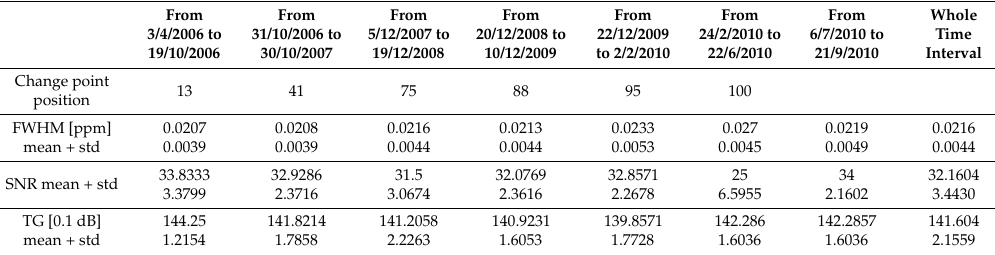
Table 2. Mean values (mean) and standard deviation (std) of full width at half maximum (FWHM), signal-to-noise ratio (SNR) and transmitter gain (TG) of the spectra averaged for the time intervals detected by the change point analysis. FWHM and SNR (the ratio of the maximum in the spectrum-minus baseline over the analysis window to twice the root mean squares of residuals) are the main spectral quality parameters determined with use of Linear Combination Model (LCModel) [24].